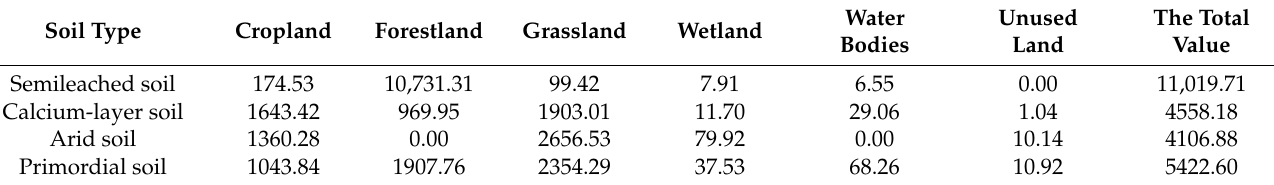
Table 8. ESV per unit area of different soil types. Unit: CNY/hm 2